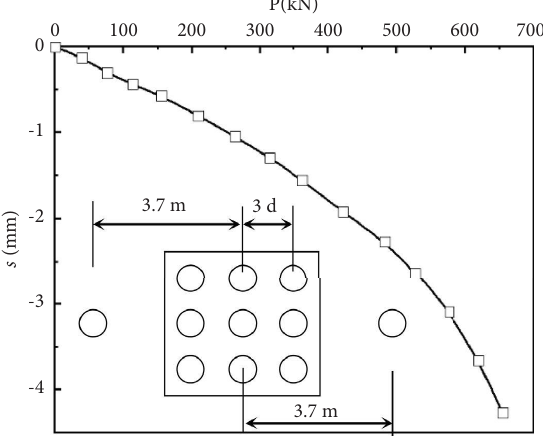
Figure 7: Comparison of the capacity of a single model